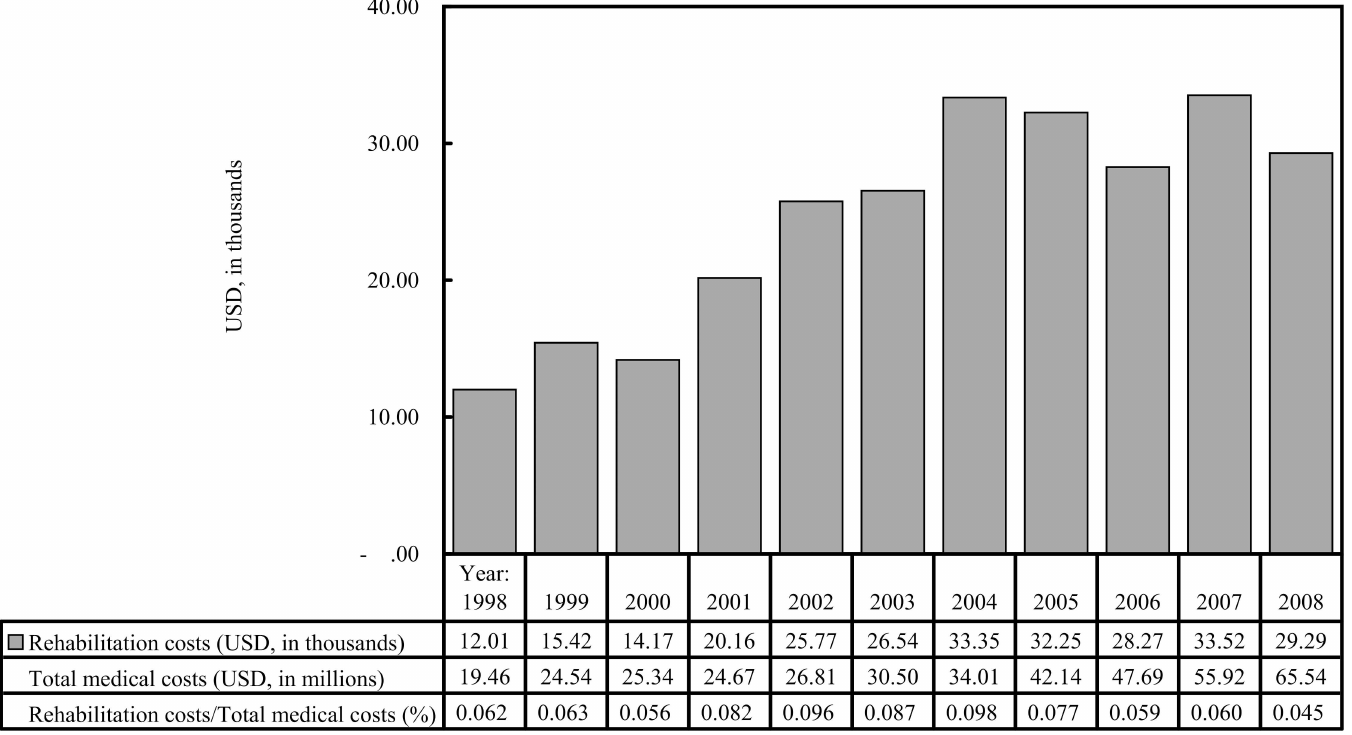
Fig 2. Annual rehabilitation costs and total medical costs in patients with hemophilia A from 1998 to